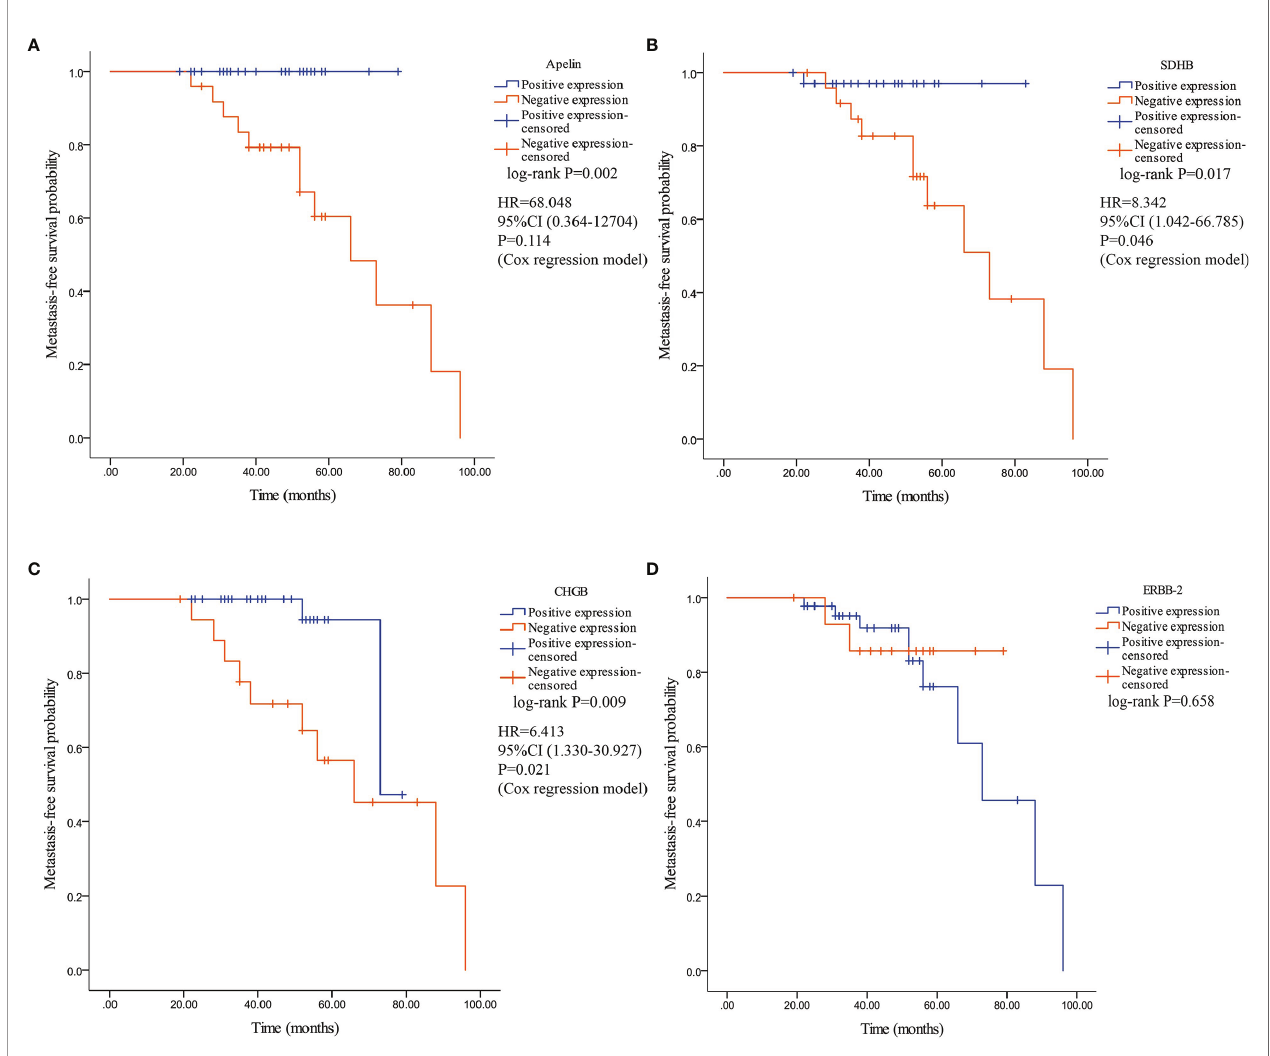
FIGURE 7 | Kaplan – Meier survival curve and their related Hazard ratio in patients with PPGLs. Survival curves were plotted as graphs according to the expression of Apelin, SDHB, CHGB and ERBB-2. (A) Kaplan – Meier survival curve and related Hazard ratio according to the expression of apelin. (B) Kaplan – Meier survival curve according and related Hazard ratio to the expression of SDHB. (C) Kaplan – Meier survival curve and related Hazard ratio according to the expression of CHGB. (D) Kaplan – Meier survival curve according to the expression of